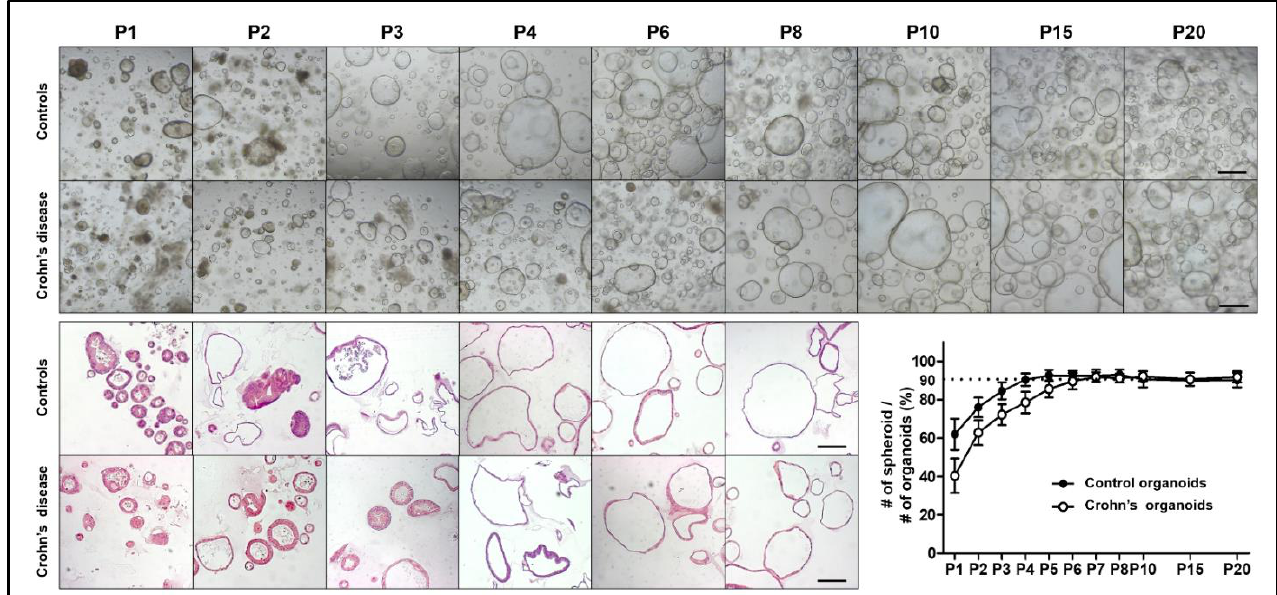
Figure 2. Long-term culture of control and CD patient-derived organoids. Bright field and H&E staining images of control and CD patient-derived organoids according to the passages. After six passages, the morphology of control and CD patient-derived organoids became identical. Scale bar = 200 μm.